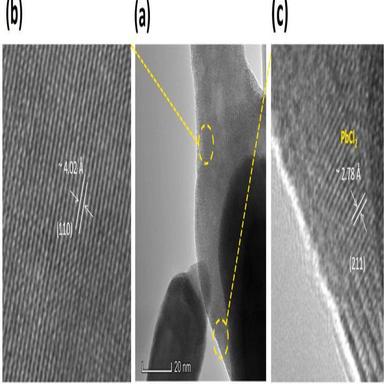
a) HRTEM image of MAPbCl3 powder perovskite, b) the interplanar spacing of 4.02 Å corresponding to the (110) plane of the MAPbCl3 phase and c) the interplanar spacing of 2.78 Å corresponding to the (211) plane of the PbCl2 secondary phase.